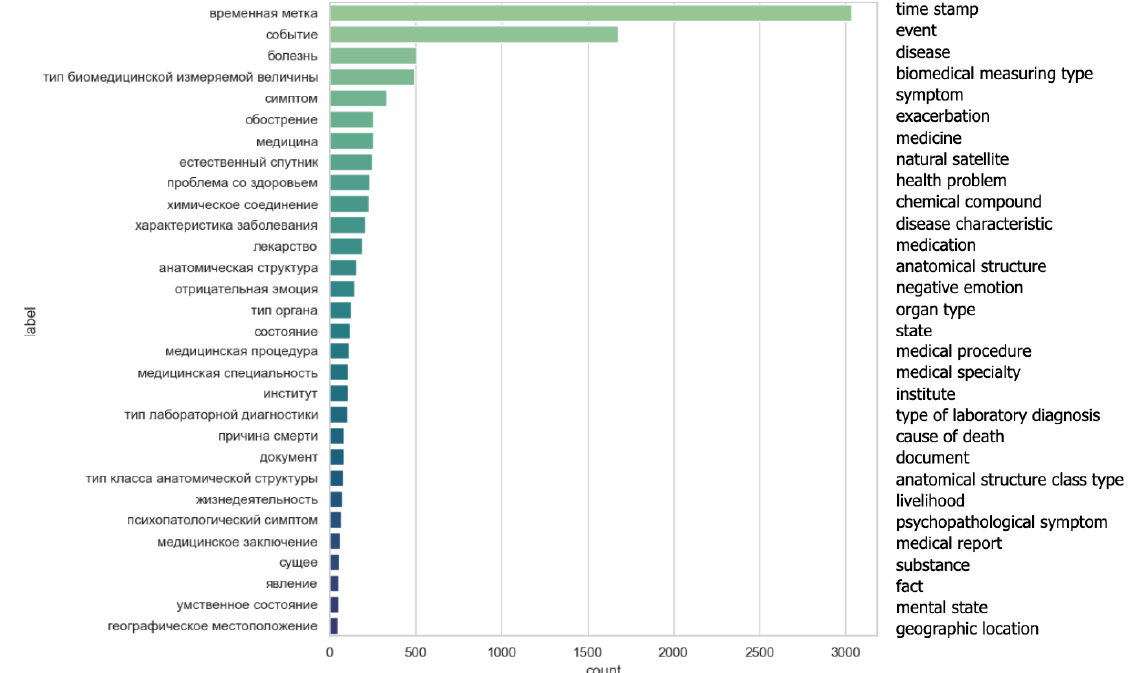
Figure 14. The 30 most common labels sorted by their frequency in a result set. We randomly generated a validation set of 500 sentences assigned labels with Wikidata and domain vocabularies. Manually validating, we decided whether a label is relevant to the context or not. As expected, classes of diseases, symptoms, laboratory tests,